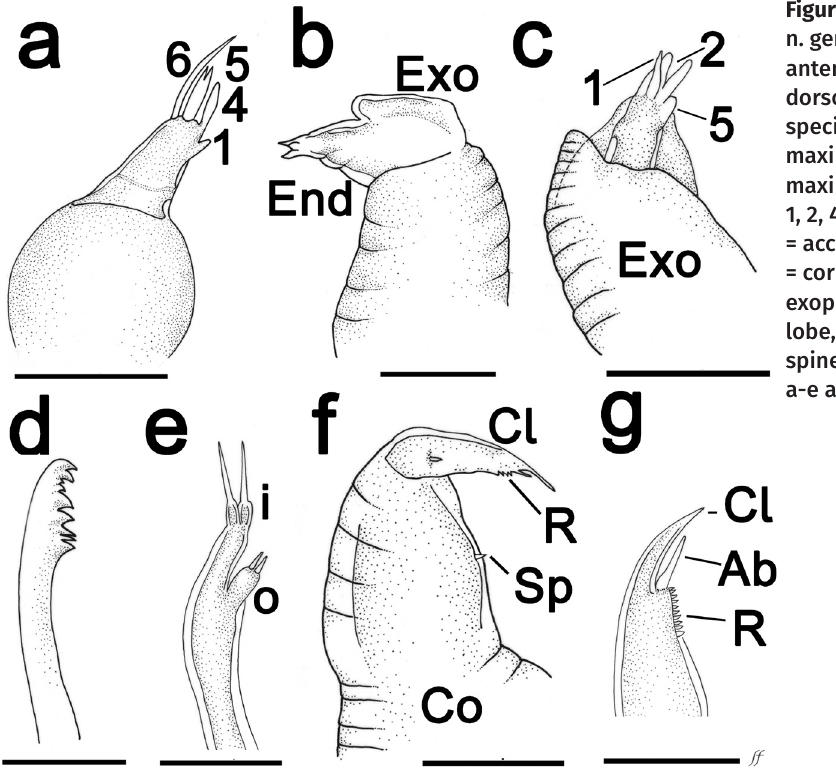
Figure 2. Female Praeclavella nasalis n. gen. et sp., ( a ) antennule; ( b ) antenna, lateral view; ( c ) antenna, dorsolateral view (different specimen); ( d ) mandible; ( e ) maxillule; ( f ) maxilliped; ( g ) claw of maxilliped, detail. Abbreviations: 1, 2, 4, 5, 6 = distal armature, Ab = accessory barb, Cl = claw, Co = corpus, End = endopod, Exo = exopod, i = inner lobe, o = outer lobe, R = row of denticles, and Sp = spine on myxal area. Scale bars: Fig. a-e and g= 25 µm, Fig. f= 50